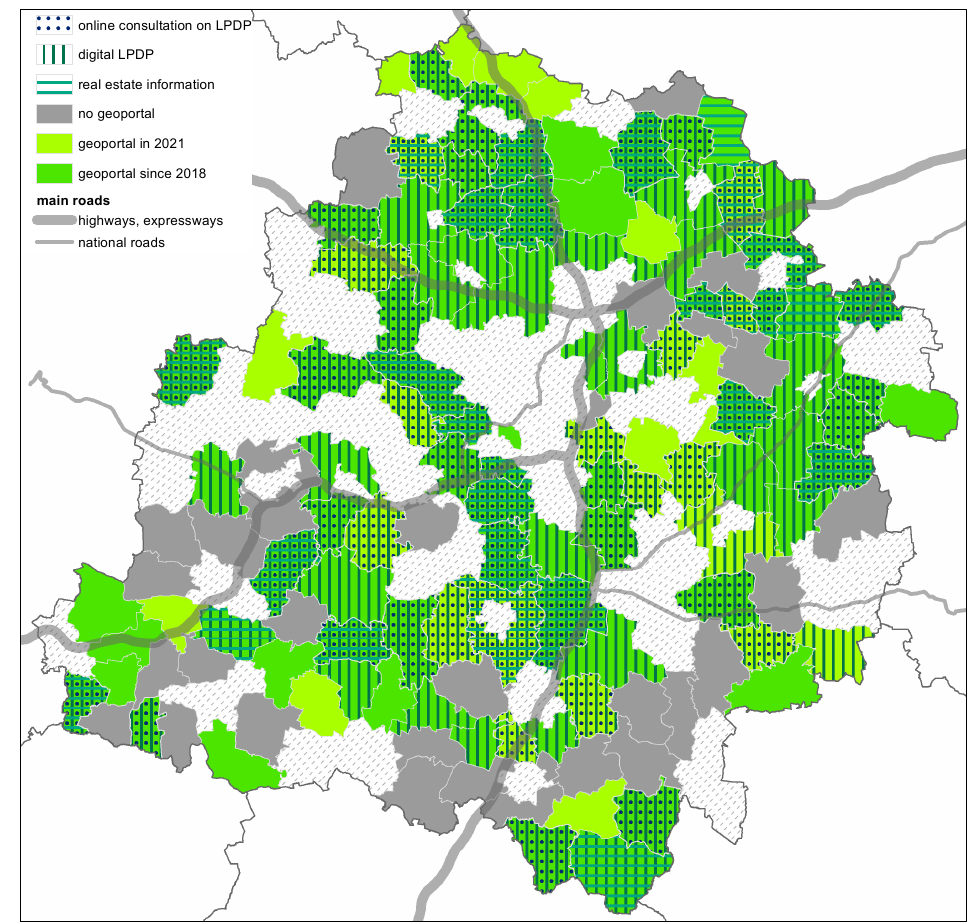
Figure 7. Geoportals run by rural gminas across the space of the Łód´z region in